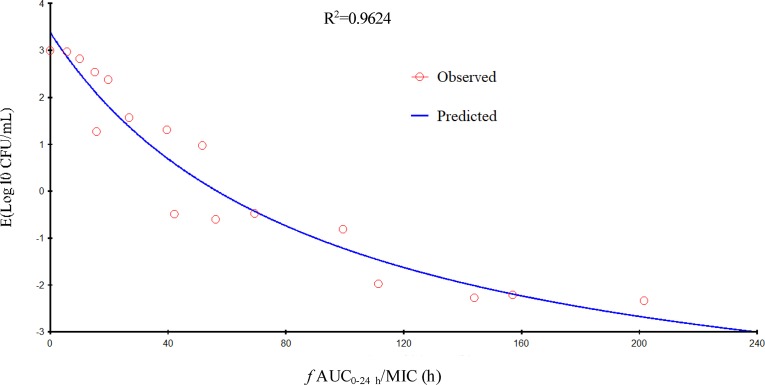
Relationship of f AUC24/minimum inhibitory concentration (MIC) for Pasteurella multocida NM-5-7 with the change in the log10 number of colony-forming unit (CFU)/lung after 24 h of therapy. R
2 is the correlation coefficient.